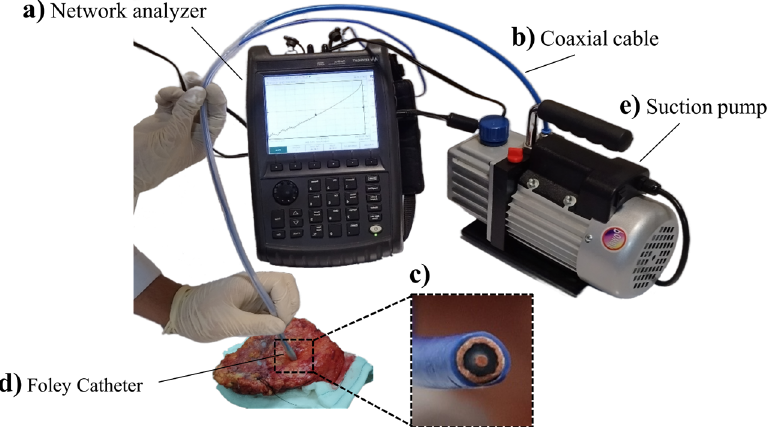
Figure 1. GHz measurement system. ( a ) The used network analyzer (KeySight FieldFox N9918A). ( b ) The open-ended coaxial cable (Semi-Flexible Cable 670-086 SXE). ( c ) Magnified view of the coaxial cable. ( d ) A Foley catheter modified for applying suction thoroughly. ( e ) Suction pump.